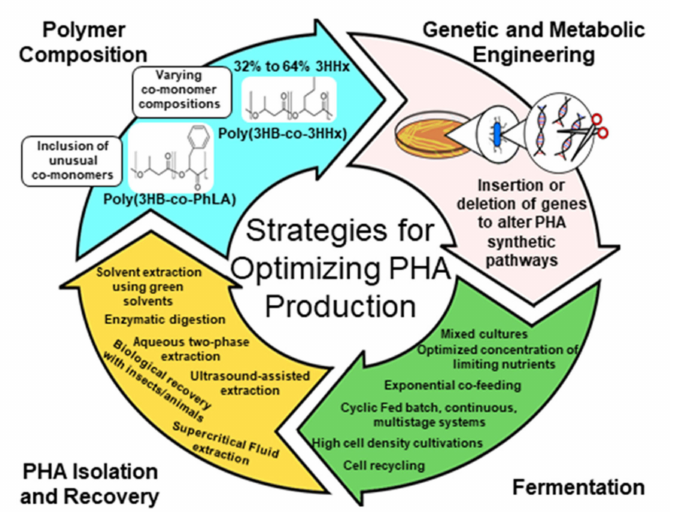
Figure 8. Key areas of PHA production to optimize to obtain high-yields of PHA. To compete with petroleum-based plastics whilst remaining as environmentally friendly as possible, PHA production requires constant innovation and optimization in four major areas. The cyclic arrows illustrate that any modification to one of the four categories will affect the following stage of production. The strategies presented herein have been proposed due to the published success regarding improved PHA production yields or PHA